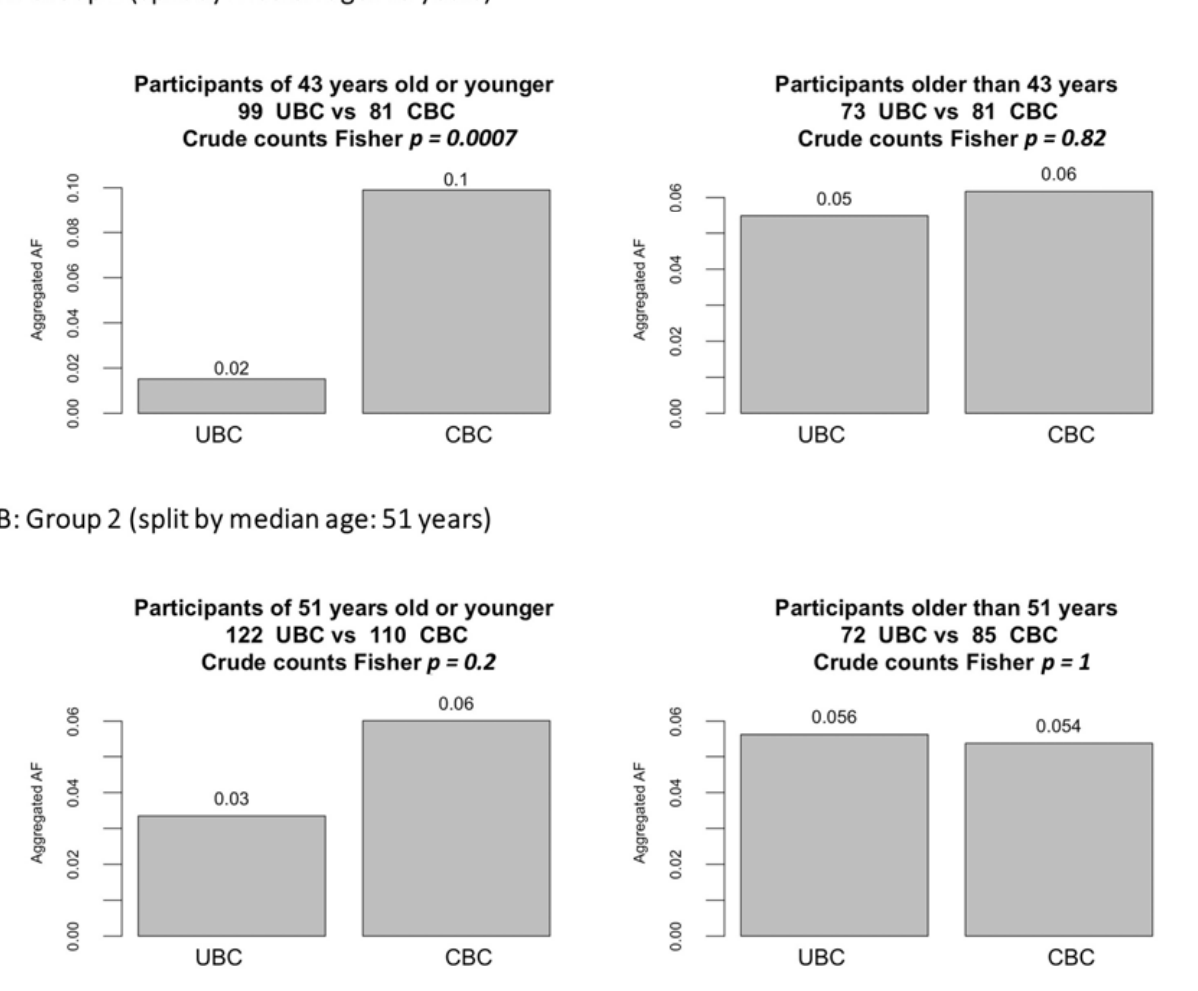
Figure 2. Burden of PGVs stratified by age. Figure note: Each group was split by median age; then, PGVs burdens were evaluated in the subgroups.